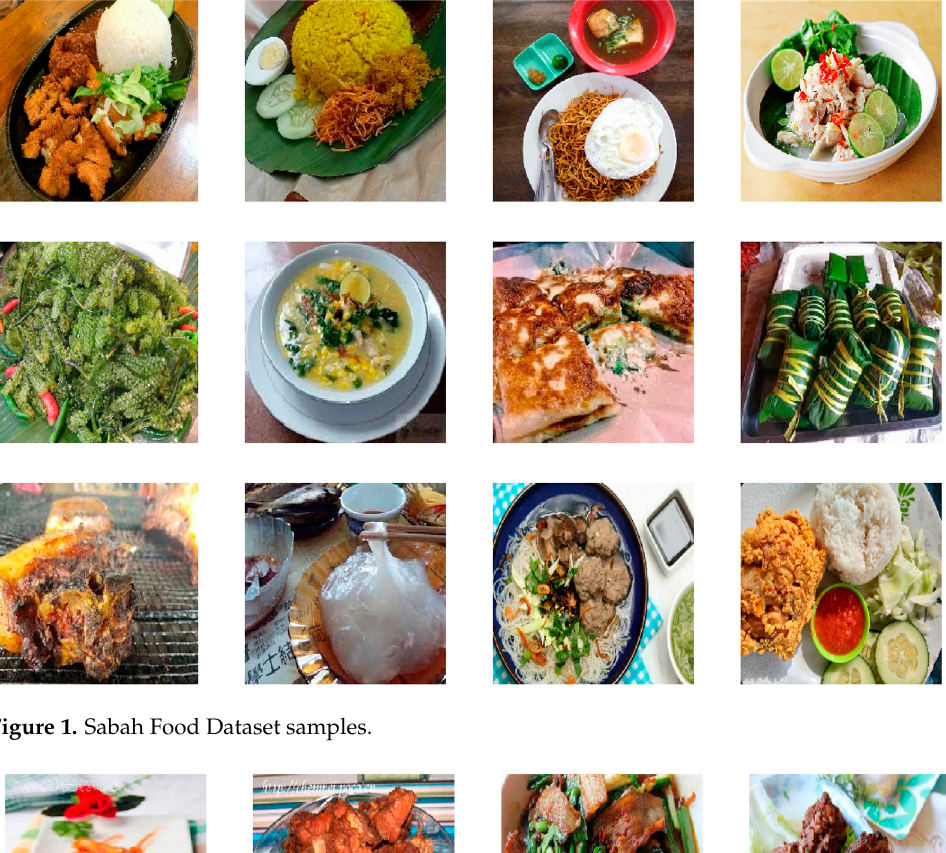
Figure 1. Sabah Food Dataset samples.